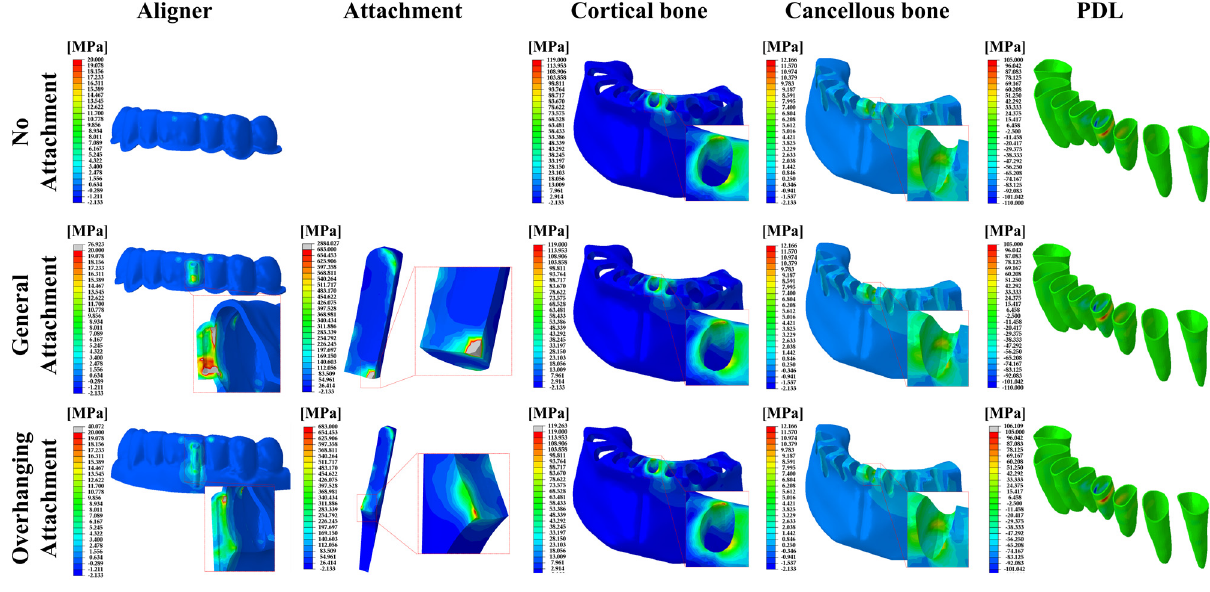
Figure 5. FE results of the stress distributions for the components of the orthodontic treatment model in the 0.5 mm aligner models. The aligner and attachment were expressed as PVMS values, and the bones (cortical and cancellous) and PDL were expressed as MPS values.